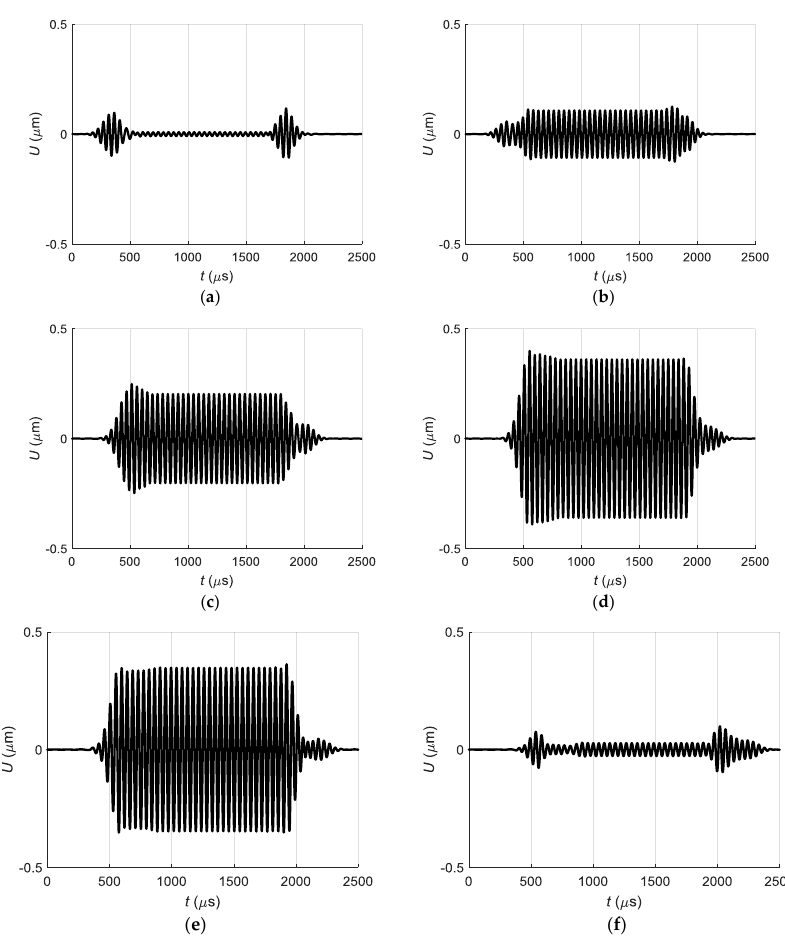
Figure 16. Partial normal displacement signals U at the point P ND , generated by different array elements: ( a )—element 8; ( b )—element 7; ( c )—element 5; ( d )—element 3; ( e )—element 2; ( f )—element 1.